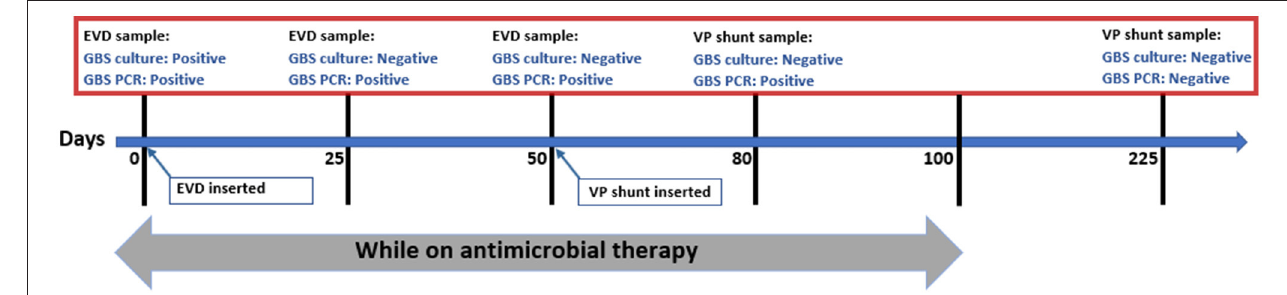
FIGURE 1 | Time-line of patient’s